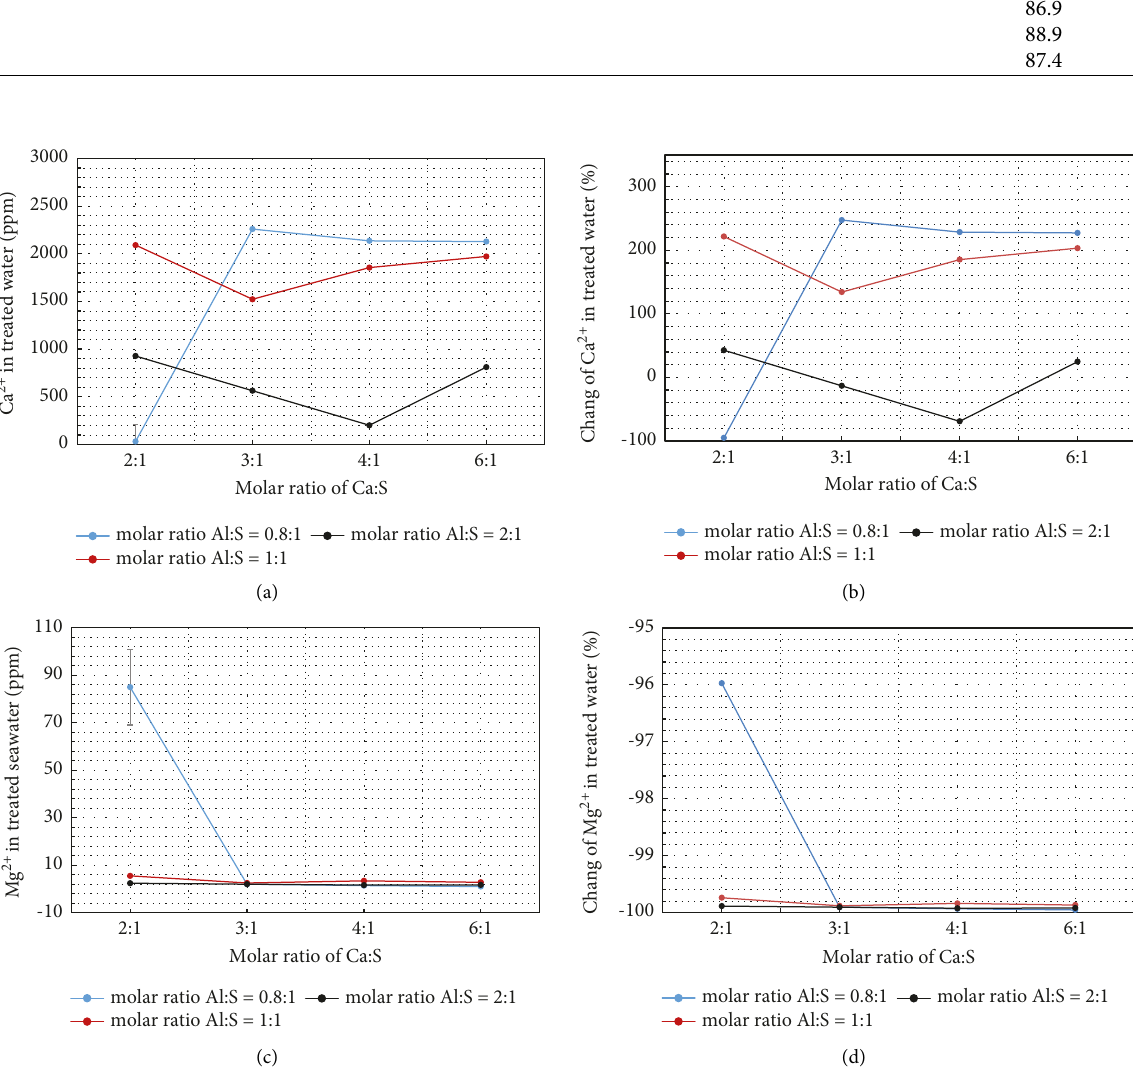
Figure 6: Calcium and magnesium concentrations in treated seawater. The original concentration of Ca 2+ and Mg 2+ in seawater is 650ppm and 2,100ppm,